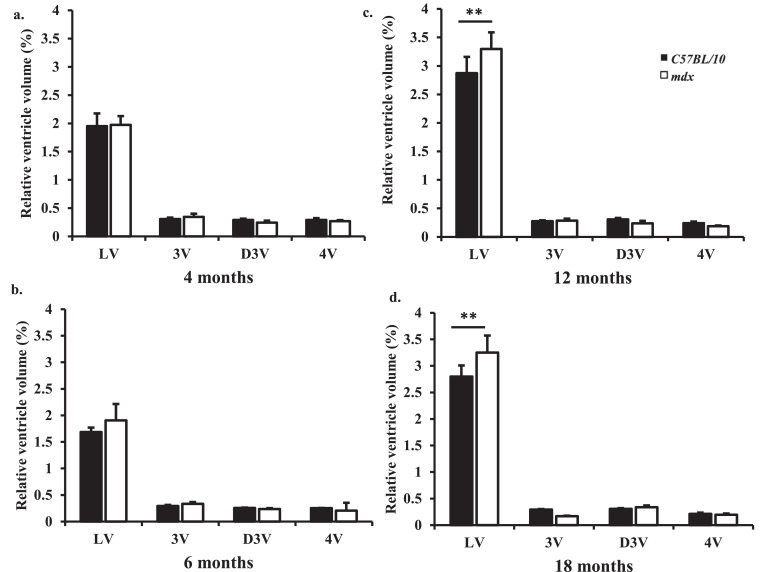
a–d: Bar graphs displaying relative ventricle volume between 4 and 18 months old. LV= lateral ventricles, 3V= third ventricle, D3V= dorsal third ventricle and 4V= fourth ventricle. a. Relative ventricle volume at 4 months old showing no difference in ventricle volume between control and mdx mice. b. Relative ventricle volume at 6 months old showing increased volume of the LVs in mdx mice but was not found to be significant (P = 0.06). c. Relative ventricle volume at 12 months old showing increased LV volume in mdx mice compared to aged matched control mice (p<0.01). d. Relative ventricle volume at 18 months old showing increased LV volume in mdx mice compared to aged matched control mice (p < 0.01). Data presented as mean ± SEM, *p < 0.05, ** p < 0.01, n = 8 mice per genotype at each time point.